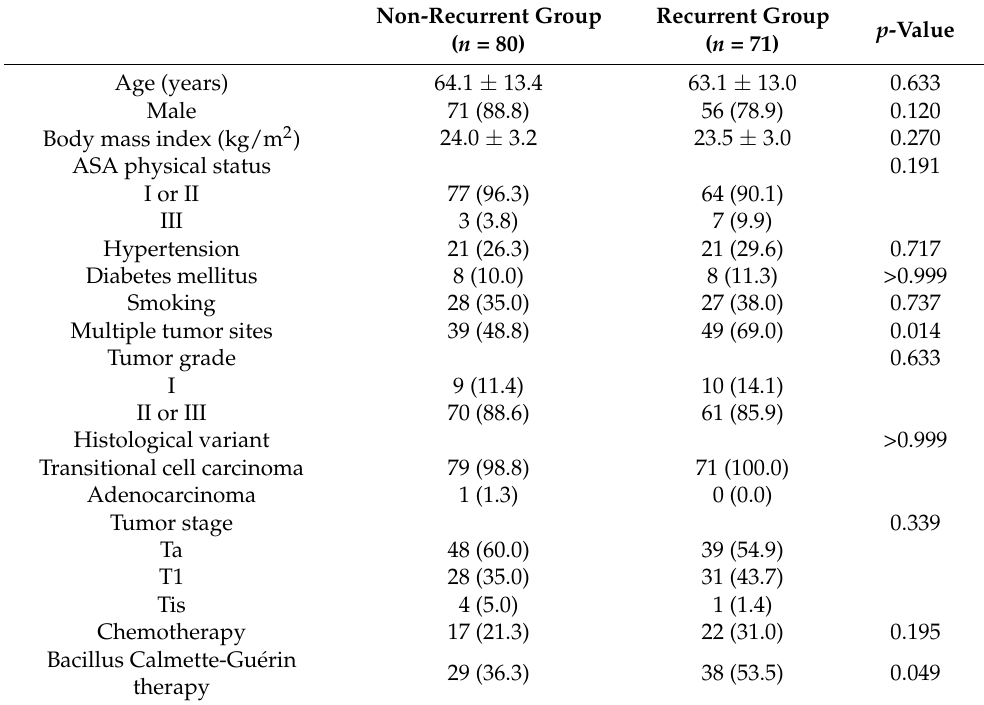
Table 1. Demographic data.